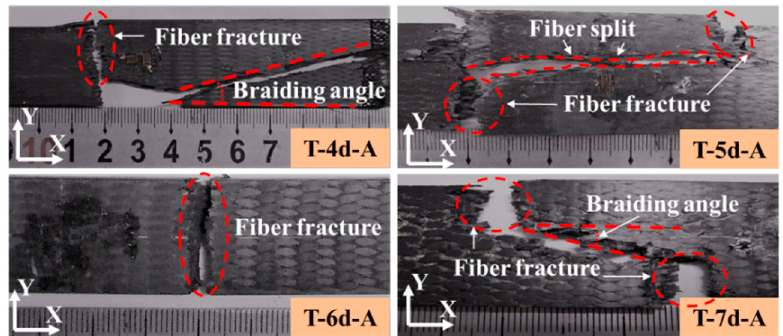
Figure 11. Tensile failure of the 3DBC with a braiding angle of 20°.